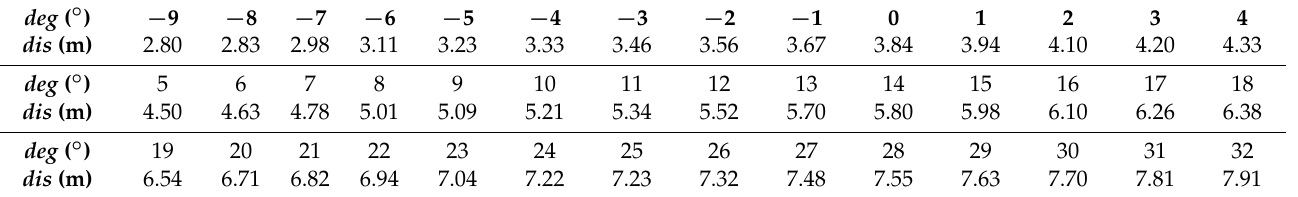
Table 2. Where dis is the distance from the landing point to the muzzle, and deg is the pitch angle of the water jet. Table 2. The measured pitch angle and the corresponding landing point distance.